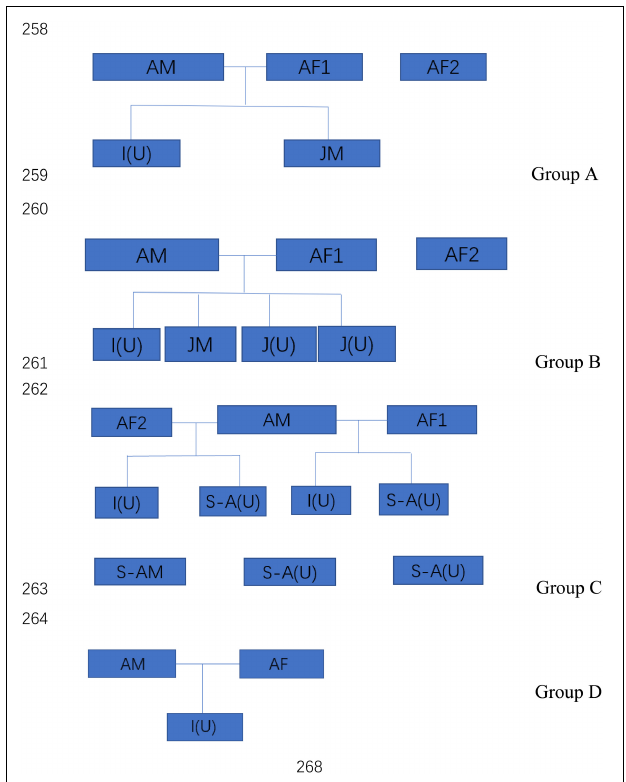
FIGURE 2 | The size and composition four wild Hainan gibbon groups. AM represents an adult male, AF represents an adult female, S-A represents a subadult, JM represents a juvenile, I represents an infant, and (U) represents an adult, subadult, juvenile, or infant of unknown sex. Infants are 0–24 months of age, juveniles are > 2–7 years of age, subadults are > 7–9 years of age, and adults are > 9 years of age.